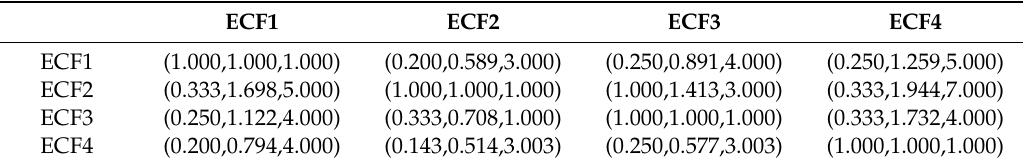
Table A5. Fuzzy pairwise comparison with respect to economic criteria (ECF).